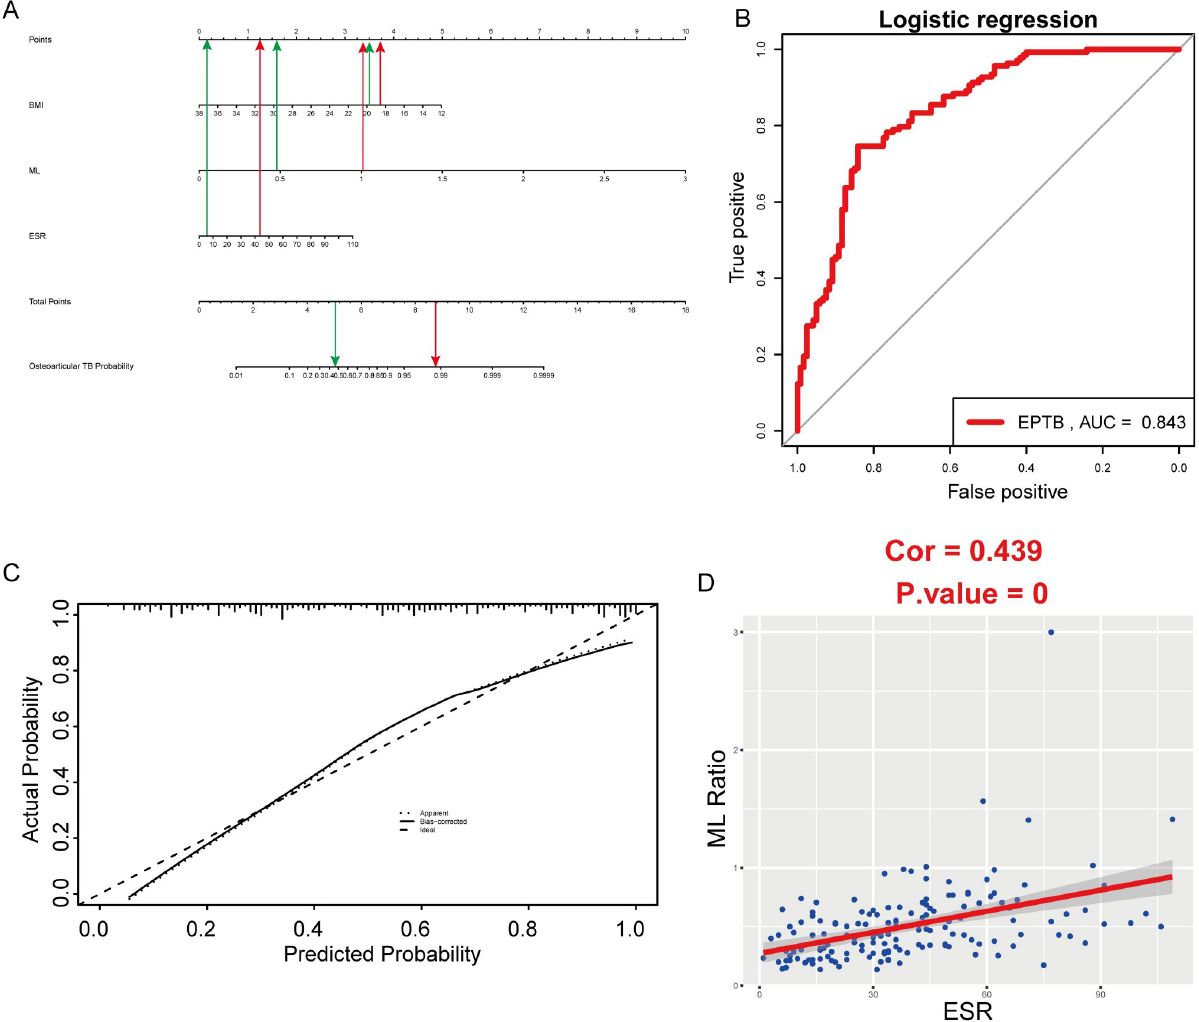
Fig 3. Nomogram and correlation analysis. (A) Nomogram for predicting osteoarticular TB probability for clinical data; The red line represents an osteoarticular TB patient while the green line represents an non-TB patient. (B) AUCs of the nomogram for clinical data. (C) Calibration curves for predicting osteoarticular TB probability for clinical data. (D) The correlation of ML ratio with ESR. https://doi.org/10.1371/journal.pone.0252875.g003 Table 2. Univariate and multivariate logistic regression of the clinical data.